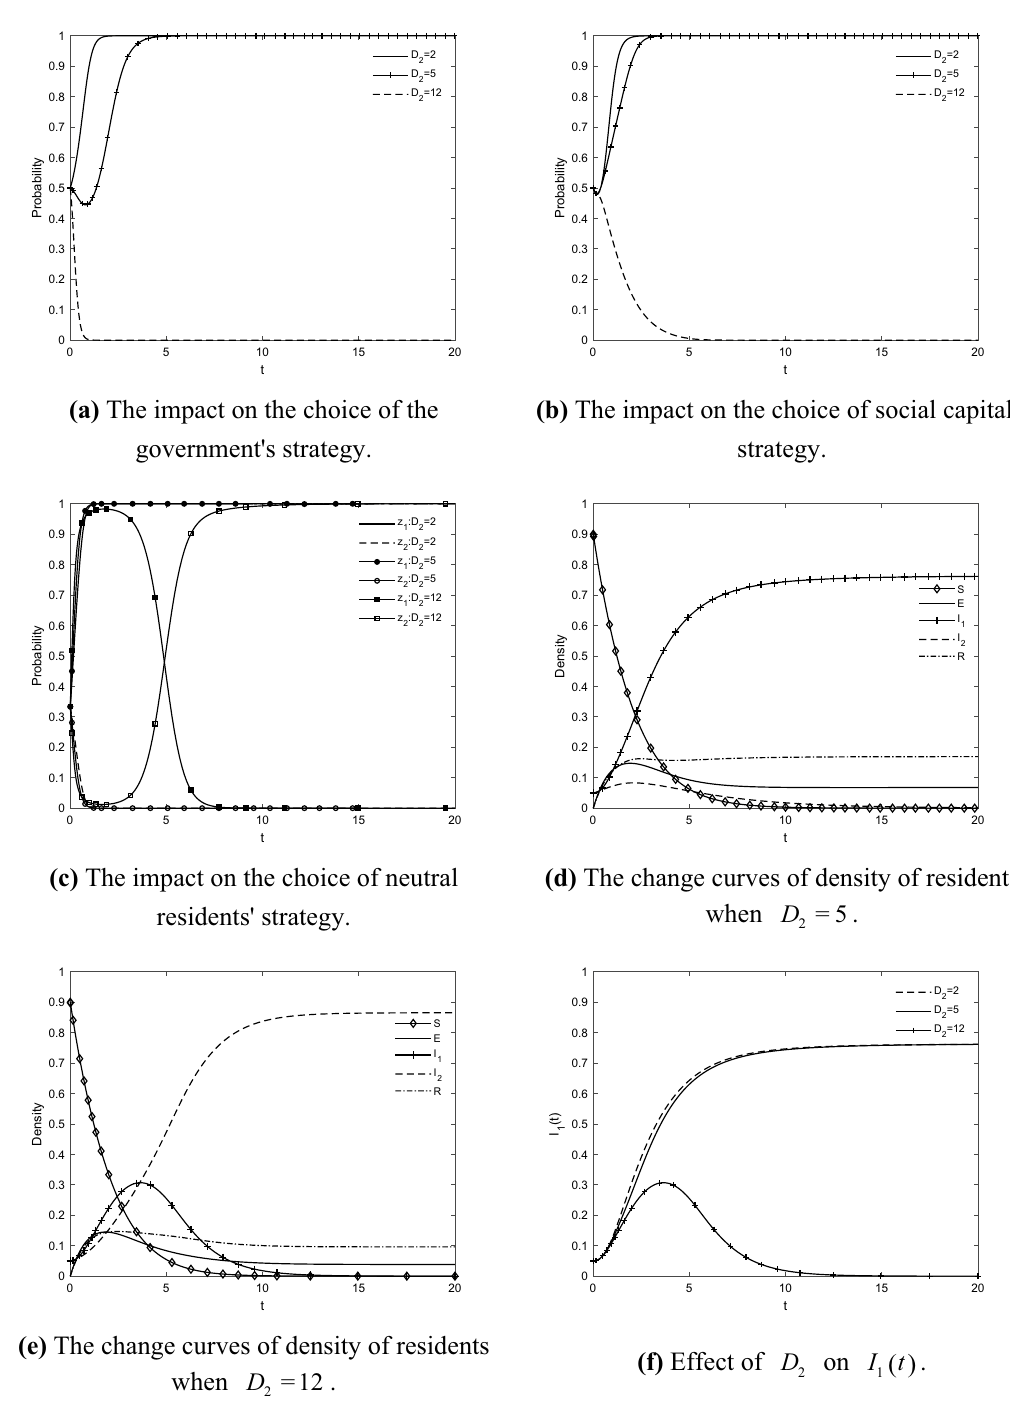
Figure 5. The impact of D 2 on the choice of tripartite strategy and residents’